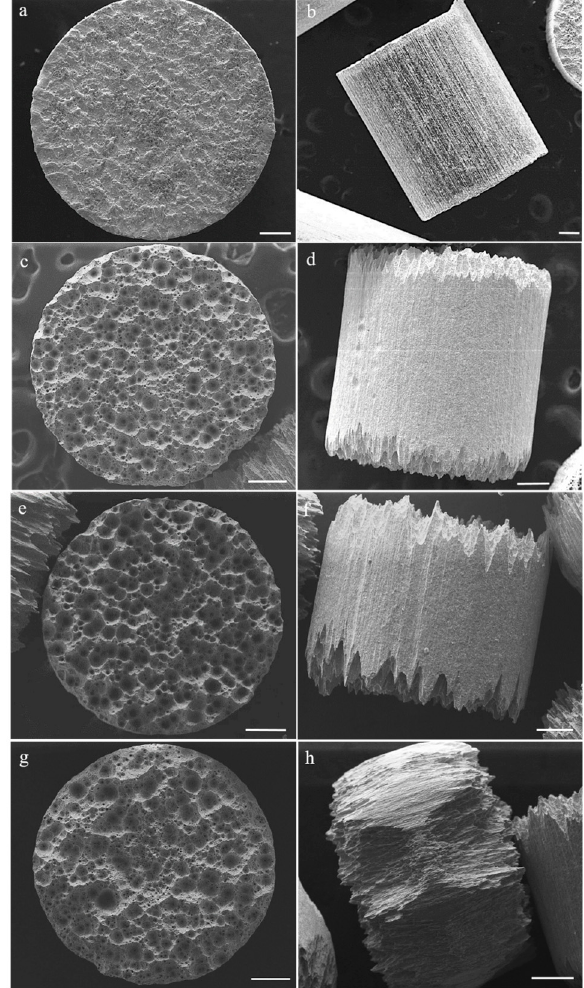
Figure 6. SEM images of some molybdenum pieces from top row to bottom row: 0 min (( a ) basal view, ( b ) lateral view) 30 min (( c ) basal view, ( d ) lateral view), 60 min (( e ) basal view, ( f ) lateral view), 120 min (( g ) basal view, ( h ) lateral view).